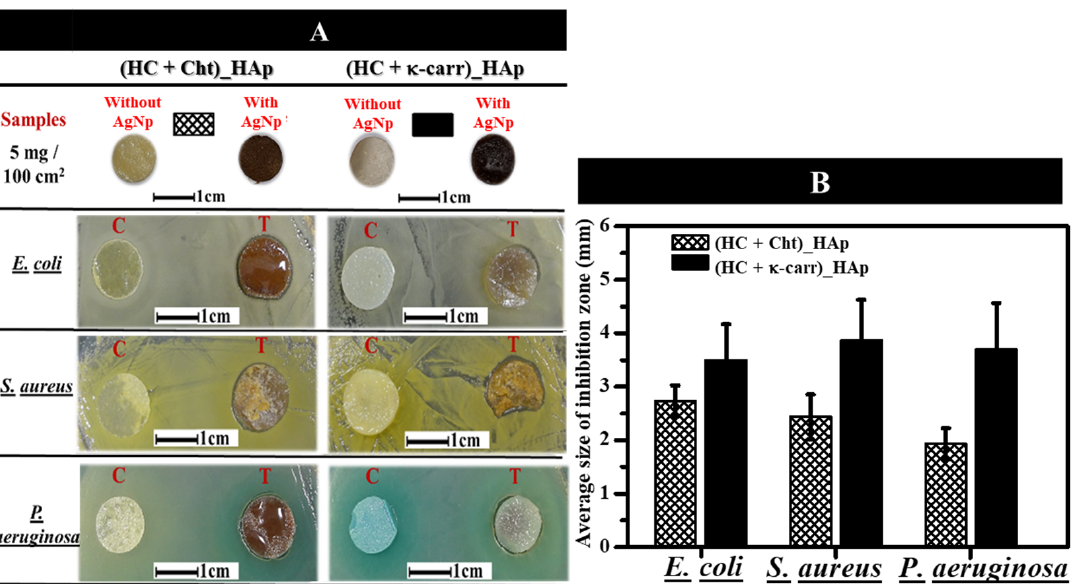
Figure 6. Antibacterial activity of the membranes. ( A ) Photography of the hybrid membranes (HC + Cht)_HAp or (HC + k ‐ carr)_HAp in the absence (C) and in the presence (T) of 5 mg of AgNPs per 100 cm 2 . Formation of a halo close to the samples in the presence of E. coli , S. aureus, and P. aeruginosa can be observed after incubation for 24 h. ( B ) Size of the inhibition zone for the hybrid membranes containing AgNPs in the presence of E. coli , S. aureus, and P. aeruginosa .